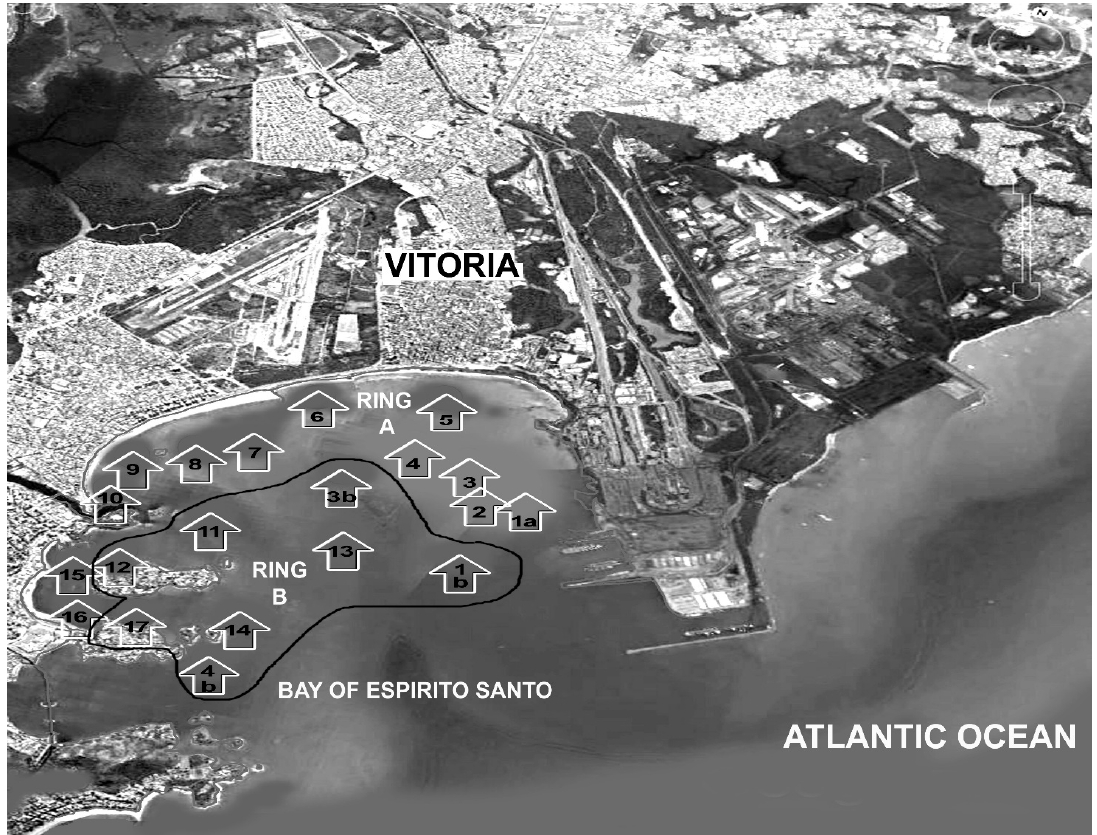
Figure 5. Location of the sediment sampling stations in Espírito Santo Bay (Municipio de Vitória, ES). Numbers within the arrows refer to the sampling station numbering. Arrows are oriented in a northern direction. Sampling stations are located at the top of each arrow.